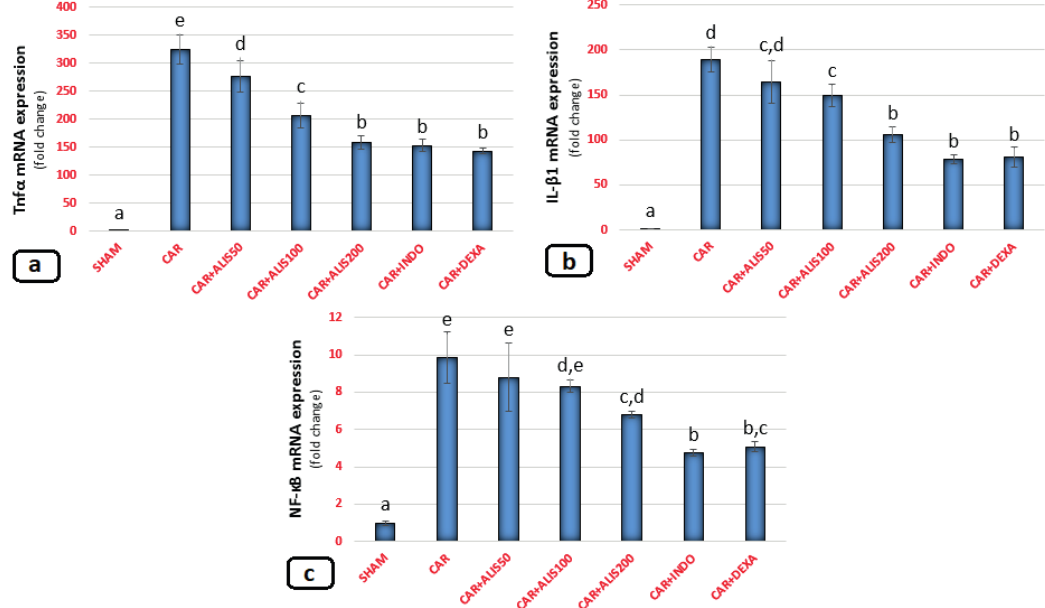
Figure 2 - Effects of Aliskiren treatments on relative mRNA expression levels of TNF-α, IL-1β, and NF-KB in rats’ lungs . Expressions of mRNAs were detected by quantitative real time PCR analysis. β-actin was used as the reference gene. Results are expressed as relative-fold compared to sham animals. Gene-specific probes were used as outlined under Material and Methods. The relative expression levels were calculated by the ΔΔCT method. SHAM: Sham- operated, ALIS: Aliskiren 50-100-200 mg/kg, CAR: Carrageenan, INDO: Indomethacine, DEXA: Dexamethasone. Means in the same column by the same letter are not significantly different to the test of Duncan (p<0.05). Results are means ±